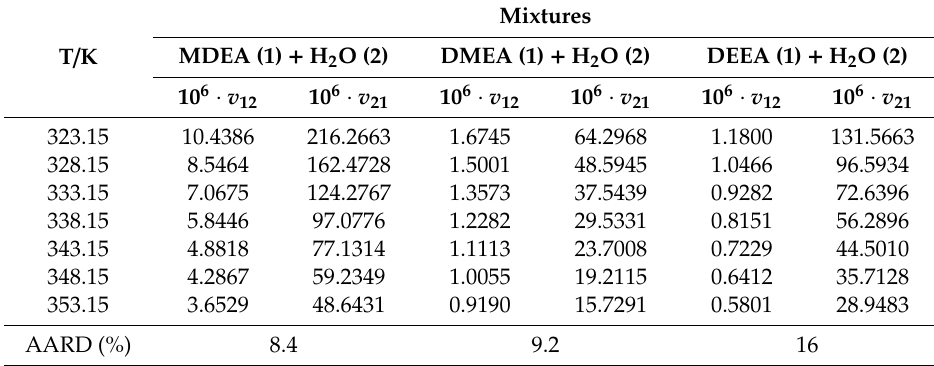
Figure S1: Comparison of measured density of MDEA (1) + H 2 O (2) mixtures with literature, Figure S2: Comparison of measured density of DMEA (1) + H 2 O (2) mixtures with literature, Figure S3: Comparison of measured density of DEEA (1) + H 2 O (2) mixtures with literature, Figure S4: Comparison of measured viscosity of MDEA (1) + H 2 O (2) mixtures with literature, Figure S5: Comparison of measured viscosity of DMEA (1) + H 2 O (2) mixtures with literature, Figure S6: Comparison of measured viscosity of DEEA (1) + H 2 O (2) mixtures with literature, Table S1: Viscosity of reference standard, Table S2: Comparison of measured density of DMEA (1) + H 2 O (2) mixtures with literature, Table S3: Comparison of measured viscosity of DMEA (1) + H 2 O (2) mixtures with